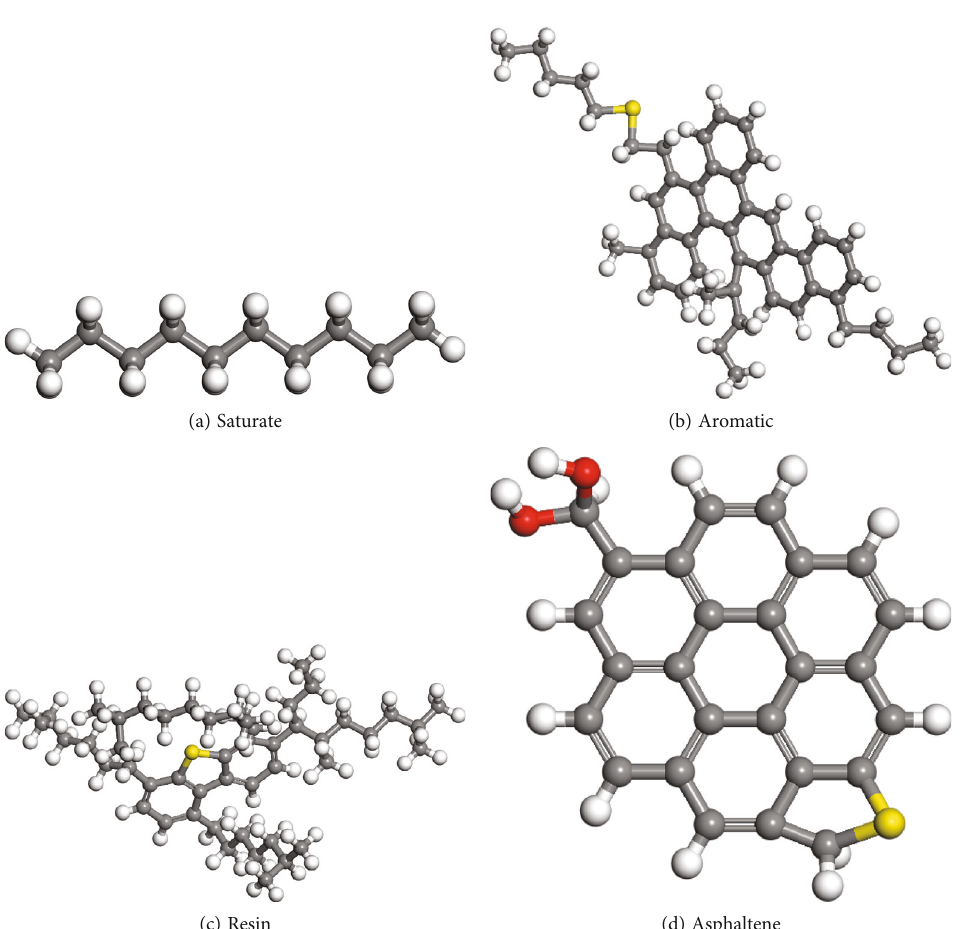
Figure 1: Simulated oil components (gray: carbon; white: hydrogen; red: oxygen; and yellow: